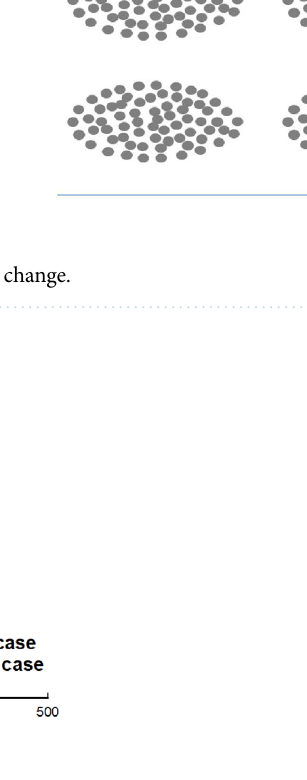
Figure 5. Permeability values at flow rates of 50, 100, 200, and 400 mm 3 /s for the gelatin-treated NC glass fiber